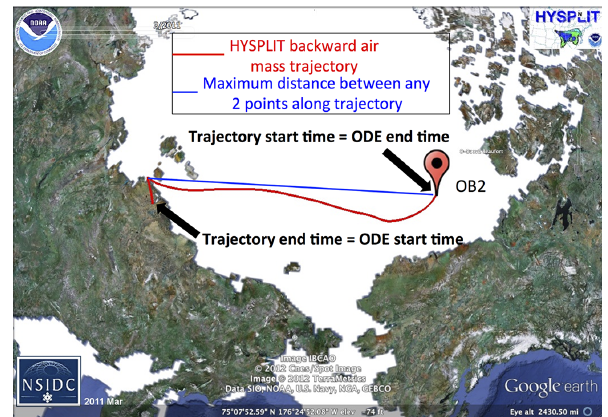
Figure 4. Example HYSPLIT backward air mass trajectory. The HYSPLIT model was run backward starting from the ODE end time until the ODE start time. ODE spatial dimensions were determined by calculating the maximum great circle distance between any two points along the trajectory.